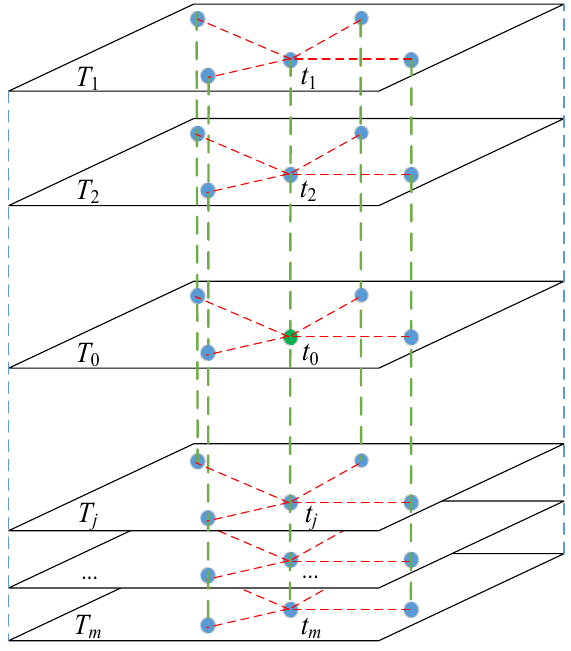
Figure 2. Interpolation in temporal dimension (blue dots represent observed records; red dotted lines are used to represent the spatial relationships). After the interpolation in the temporal dimension is finished, the interpolation in the spatial dimension will be implemented similar to that in the temporal dimension. In each homogenous sub ‐ region, the largest correlated n stations are selected to interpolate the missing value in a station,